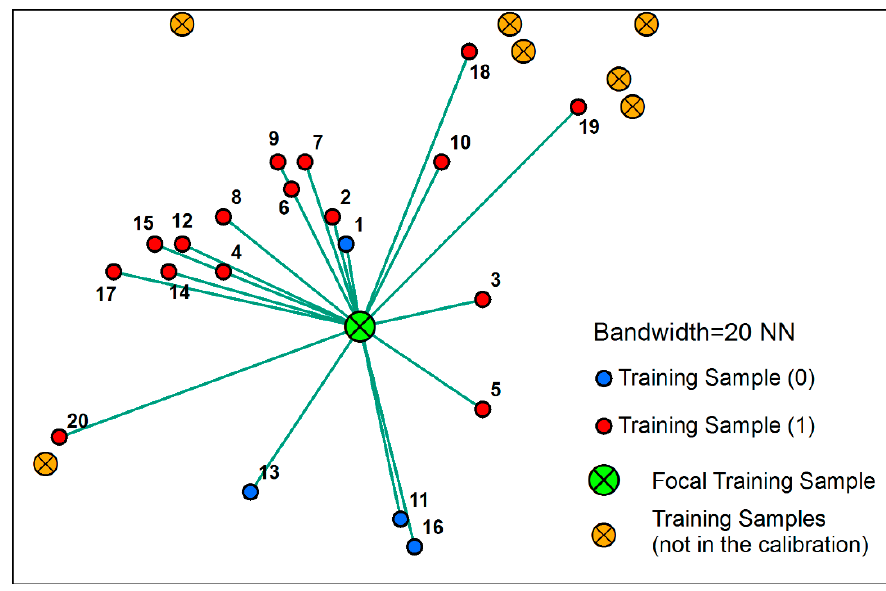
Figure 5. Method used to calibrate the LSVM model.